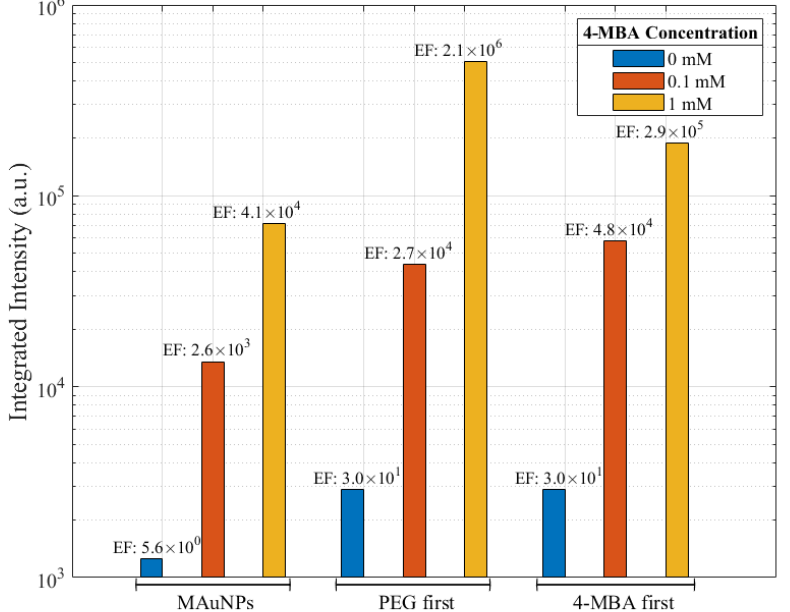
Figure 10. Comparison of integrated intensity of SERS spectra for samples incubated with 0, 0.1, or 1 mM 4-MBA. Values represent integrations from 1028 to 1128 cm − 1 . Calculated Raman enhancement factors (EFs) are transcribed above each of their respective data bars. Samples indicated as either “PEG first” or “4-MBA first” were grafted with 2 mM PEG, and the 0 mM 4-MBA sample was only grafted with PEG. It is shown for reference.